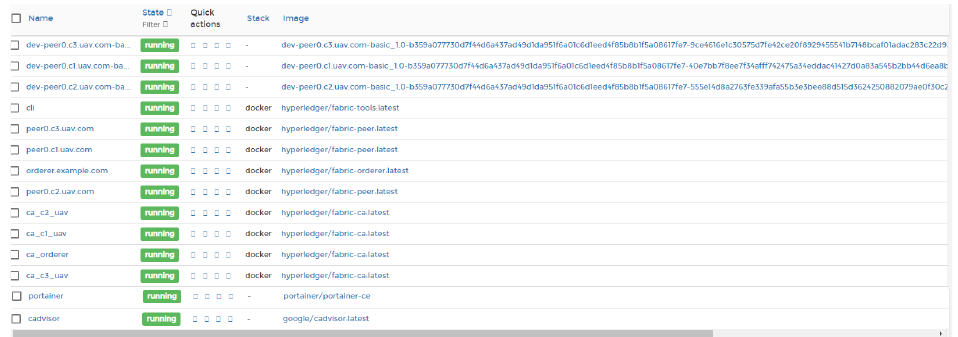
Figure 3. Blockchain Network